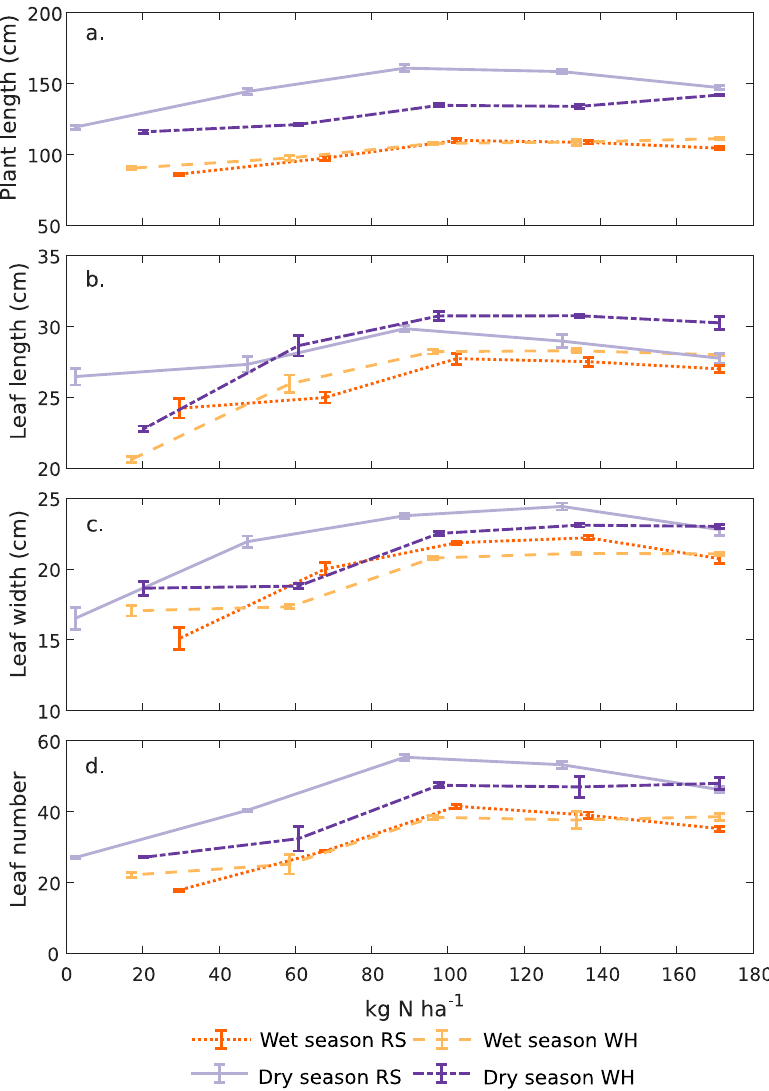
Figure 5. Plant traits as a function of total nitrogen input: ( a ) plant length, ( b ) leaf length, ( c ) leaf width, and ( d ) leaf number. Data are compared between each treatment (organic amendment made with rice straw (RS) or water hyacinth (WH)) and between growing seasons at 20 days after sowing. Vertical bars are standard errors ( n = 3).